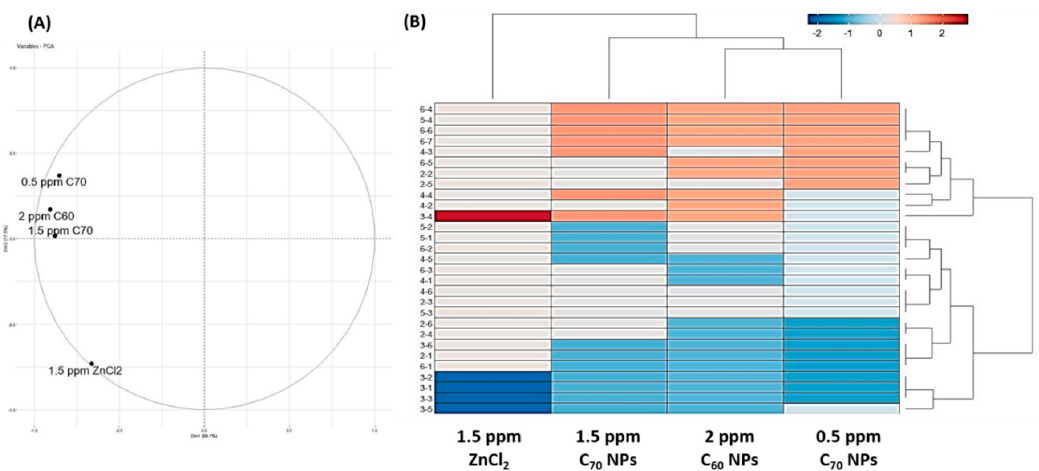
Figure 7. Comparison of behavioral alterations in zebrafish after exposing to either C 60 NPs, C 70 NPs or ZnCl 2 . ( A ) Results obtained from principal component analysis (PCA). ( B ) Results obtained from hierarchical clustering and heat map analysis.